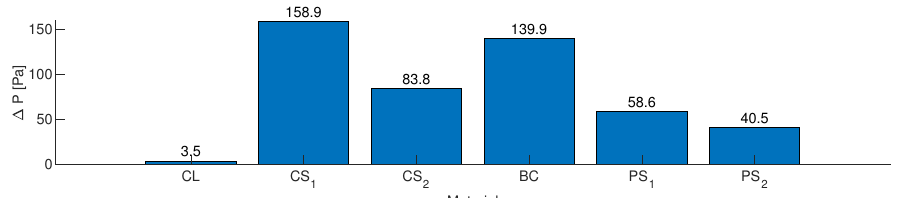
Figure 9. Pressure drop across the pads studied for a fixed value of inlet air velocity ( u = 1 m s − 1 ) and water flow ( Q = 6.2 L min − 1 m − 1 ).